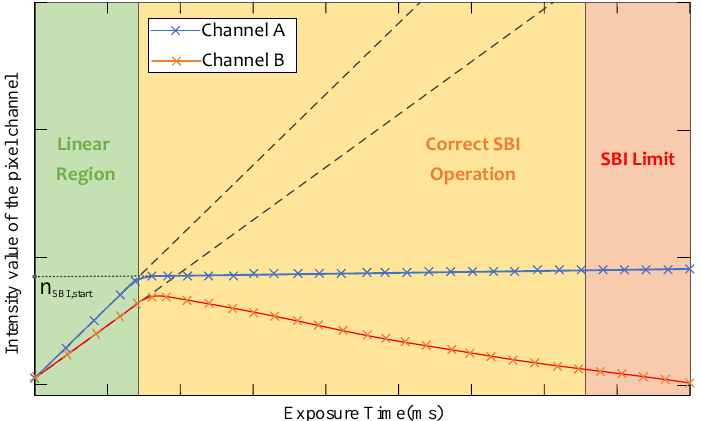
Figure 6. The structure diagram of the PMD and the schematic diagram of the influence of back- ground light on the PMD. ( a ) The structure diagram of the PMD; ( b ) the schematic diagram of the influence of background illumination on the PMD.